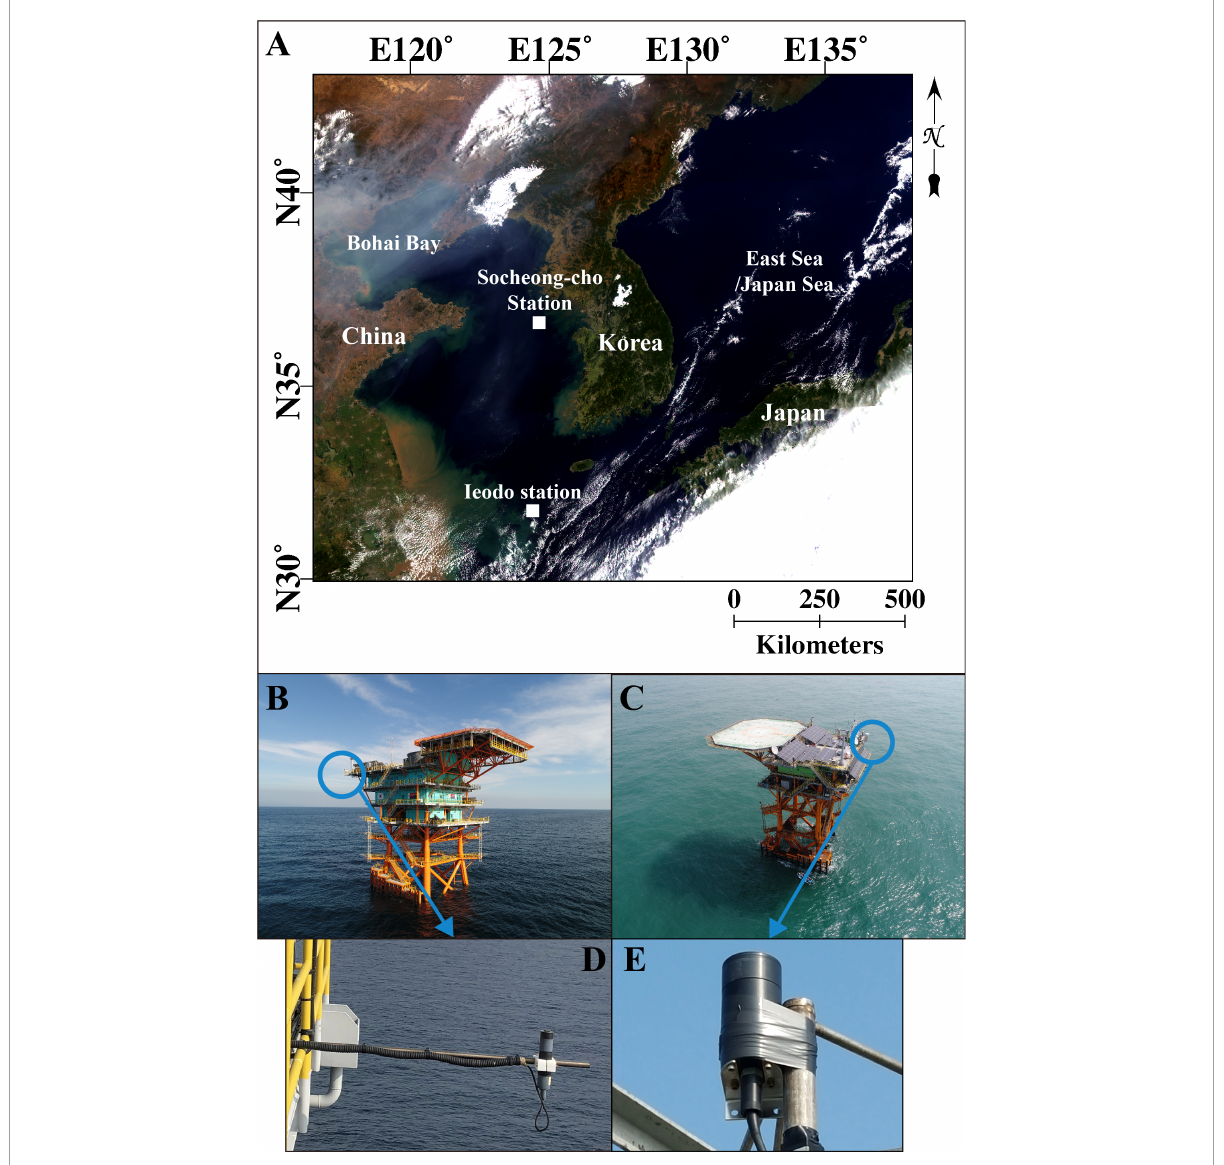
FIGURE 1 (A) Geostationary Ocean Color Imager (GOCI) image of the area around the Korean Peninsula (UTC 01:16:39, October 4, 2013). (B) Socheong-cho station (37°25’23.28”N, 124°44’16.94”E). (C) Ieodo station. Photosynthetically available radiation (PAR) sensors installed at (D) Socheong-cho and (E) Ieodo (32°7’22.63”N, 125°10’56.81”E)